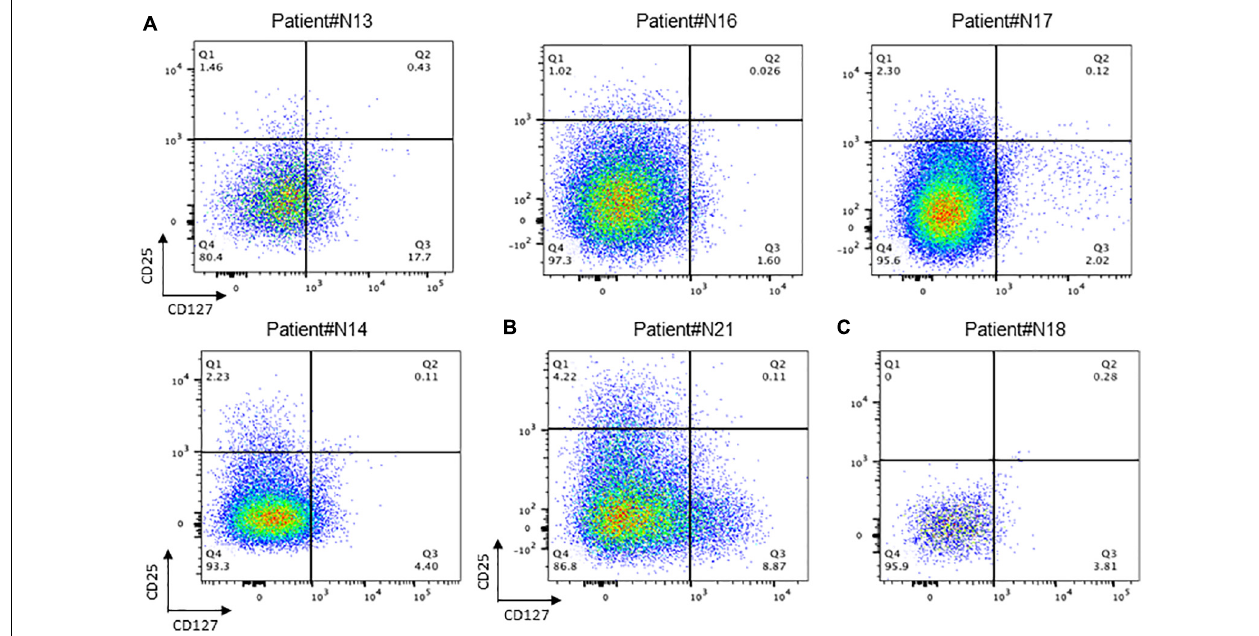
FIGURE 4 | Conception of regulation T cells in NPC tissue. (A) Flow cytometry of CD25+/CD127+ T cell in recurrent NPC tissue; (B) Flow cytometry of CD25+ /CD127+ T cell in primary NPC tissue. (C) Flow cytometry of CD25+ /CD127+ T cell in recurrent NPC tissue with